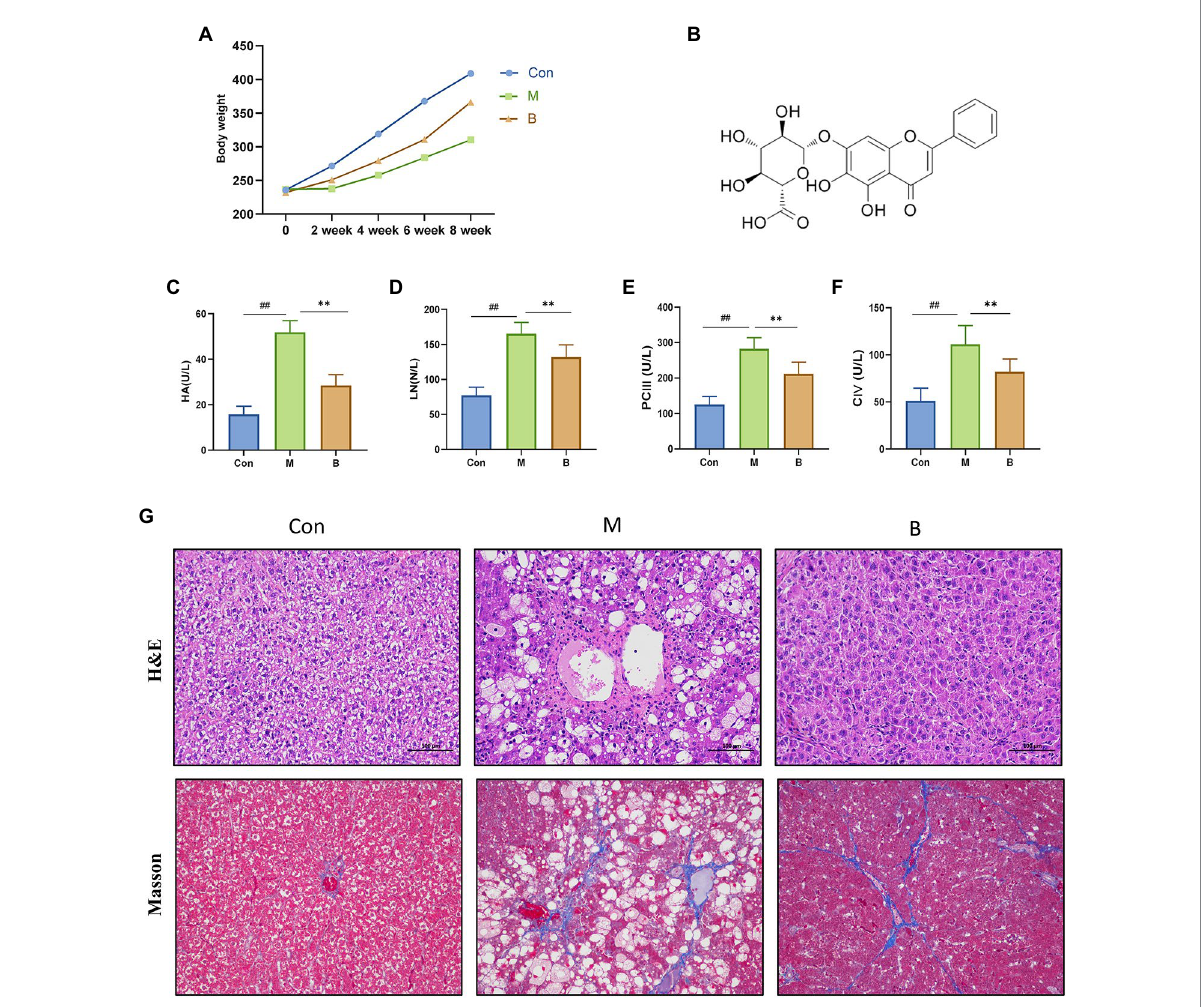
FIGURE 1 Establishment of HF model and curative effect of BA. (A) Body weight, (B) BA chemical structure, (C) Serum HA (U/L), (D) Serum LN (U/L), (E) Serum PC III (U/L), (F) Serum CIV (U/L), (G) Hematoxylin–eosin (H&E) staining and Masson staining (magnification, × 200). compared with the Con group, ## p < 0.05; ## p < 0.01; compared with the M group, * p < 0.05; ** p <